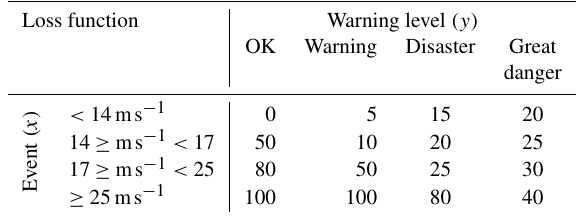
Table 1. Dummy loss function for actions associated with four Bangladesh TC warning levels and their associated wind speed in- tensity. In this case loss is defined on a 100-point scale, where 0 means no loss and 100 means maximum loss, associated with a given landfall TC